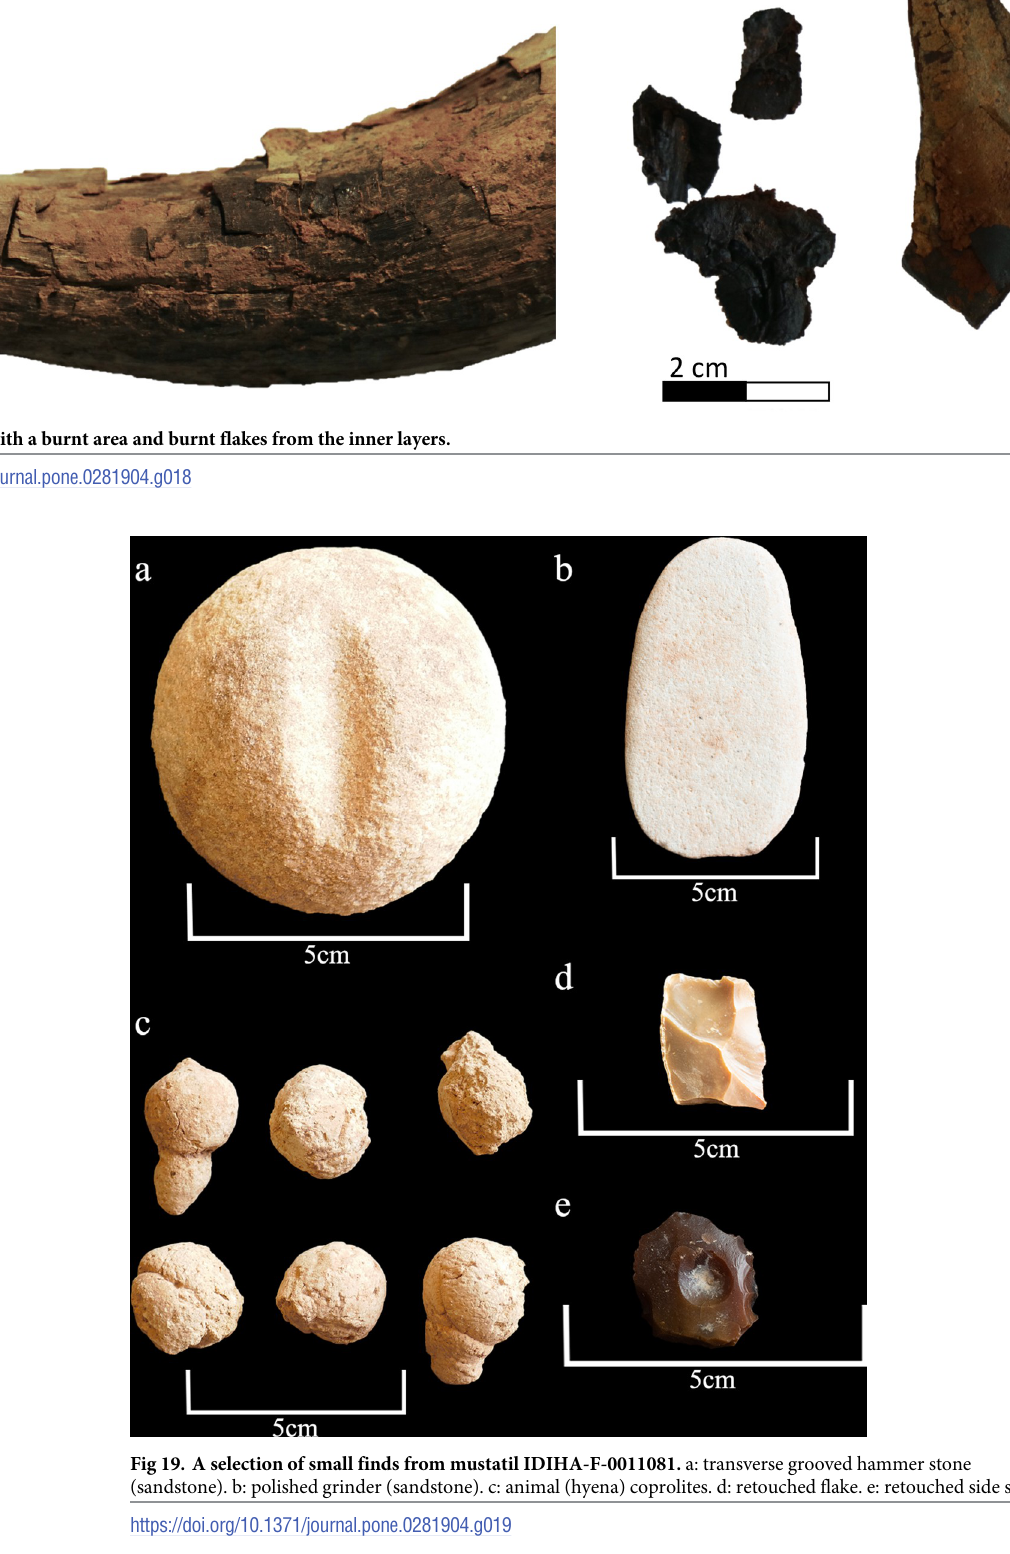
PLOS ONE | https://doi.org/10.1371/journal.pone.0281904 March 15, 2023 23 /